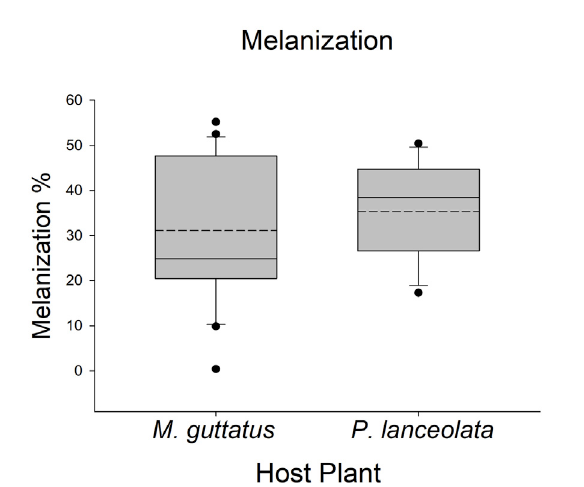
FIGURE 4 Boxplots representing the data for total phenoloxidase activity for each host plant. Solid lines in the boxes represent the median total PO and dotted lines represent the mean total PO. Total PO was higher in caterpillars reared on Plantago lanceolata .